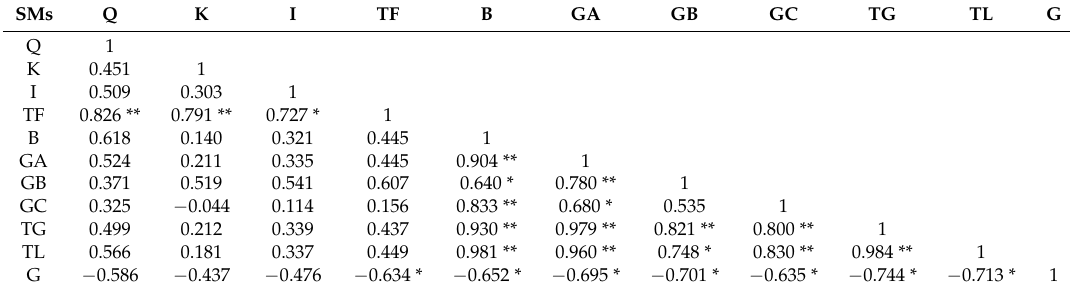
Table 3. The correlation between concentrations of SMs at the level of population ( n =